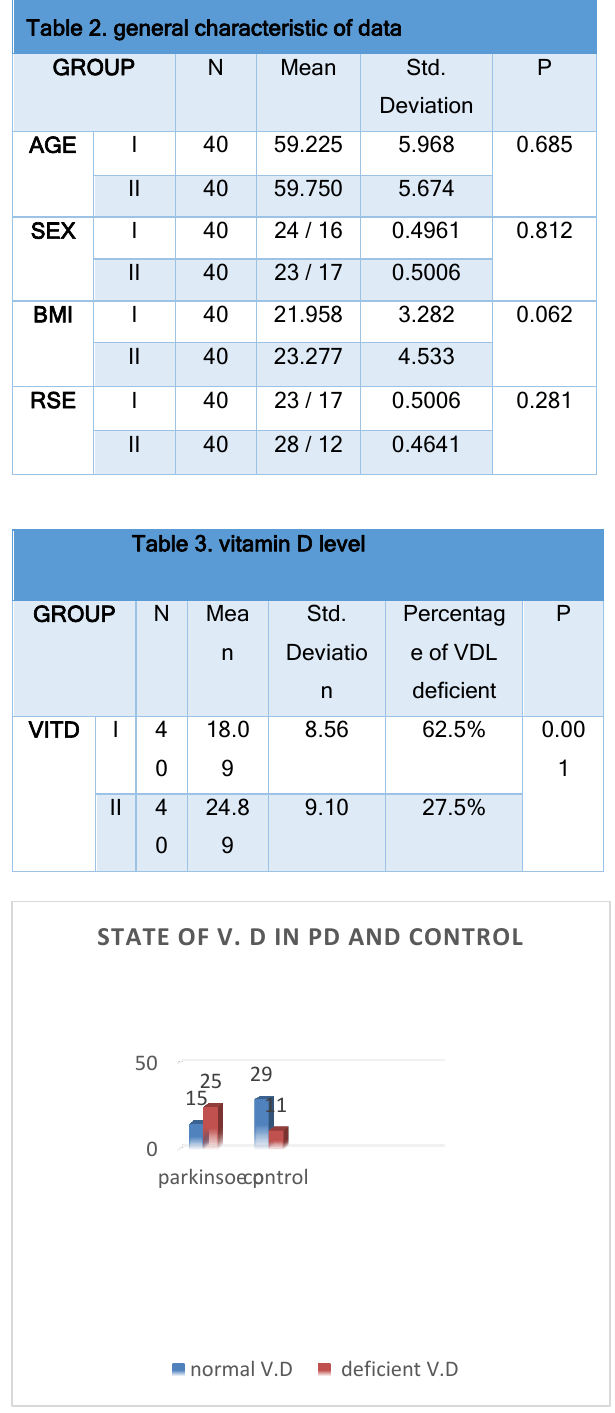
Figure 1 state of VDL in PD and